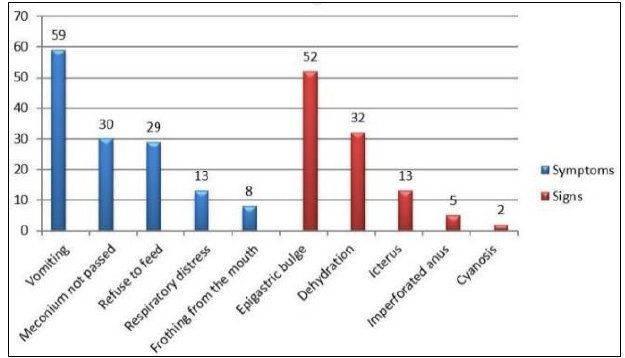
Figure 2. The spectrum of presentations of duodenal